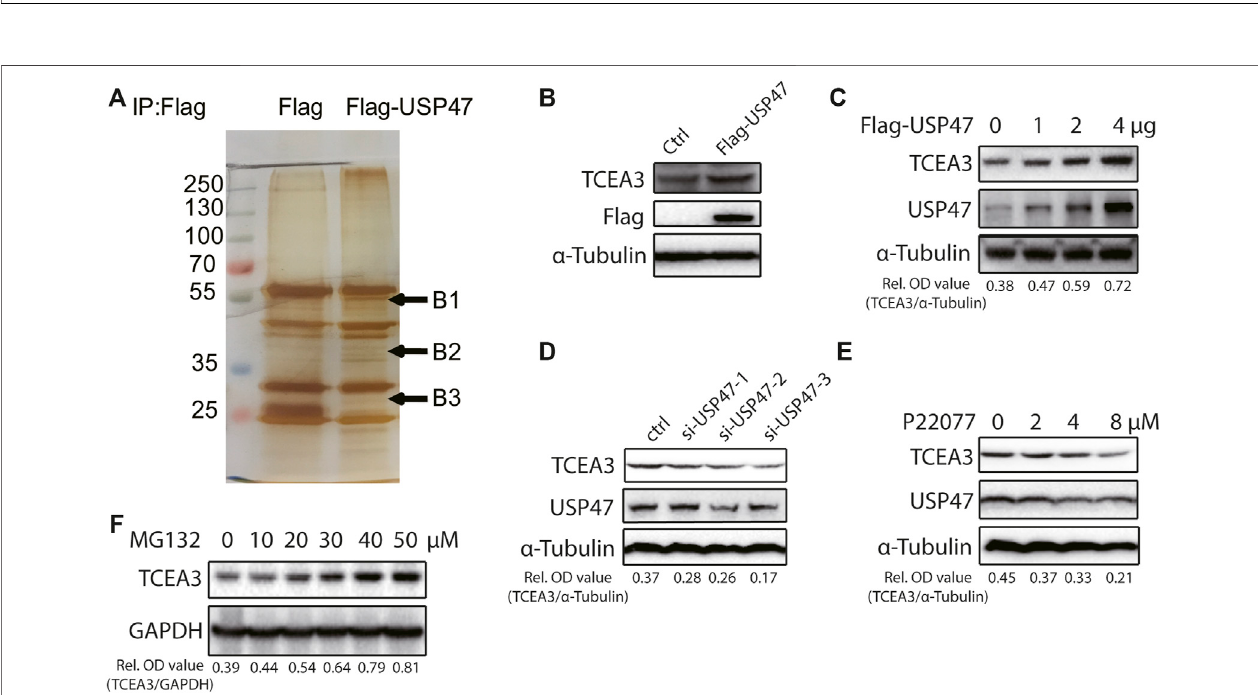
FIGURE 3 | USP47 regulated the expression of TCEA3. (A) Silver staining of lysates from HEK293T cells transfected with Flag-USP47-expressing vector for 48 h. (B) Anti-Flag immunoblotting of HCT116 cells transfected with Flag-USP47-expressing vector for 48 h. (C) The expression of USP47 and TCEA3 in HCT116 cells transfected with indicated amounts of USP47-expressing plasmid. (D) The expression of TCEA3 in USP47 HCT116 cells transfected with siRNAs against USP47. (E) Immunoblotting of TCEA3 in HCT116 cells treated with indicated amounts of USP47 inhibitor P22077 for 24 h. (F) Immunoblotting of TCEA3 in HCT116 cells treated with indicated amounts of MG132 for 6